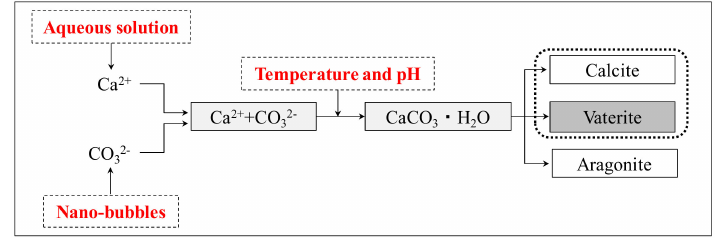
Figure 2. Process of self-healing by temperature control.